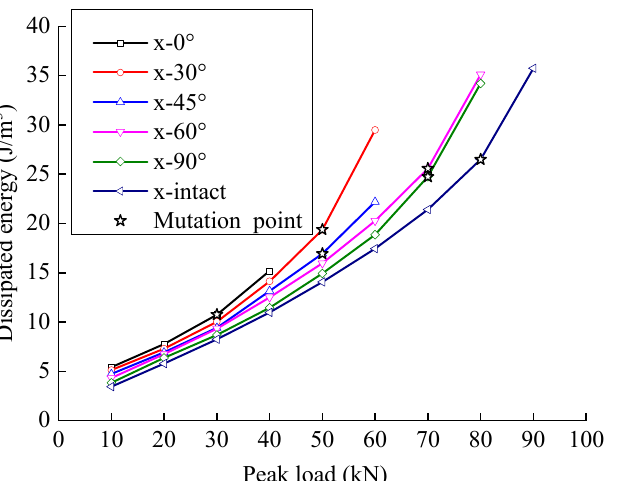
Figure 9. Elastic energy evolution curve of sandstone with different crack angles.